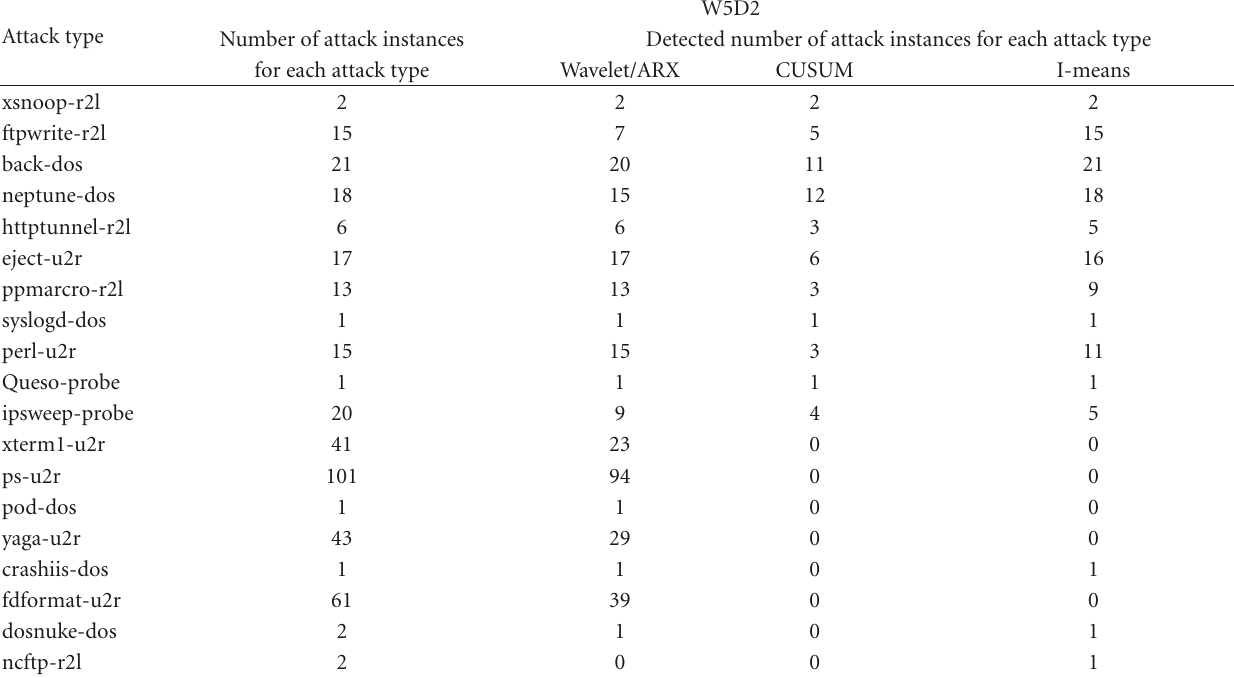
Table 13: Number of attack instances detected for each attack type by di ff erent approaches.